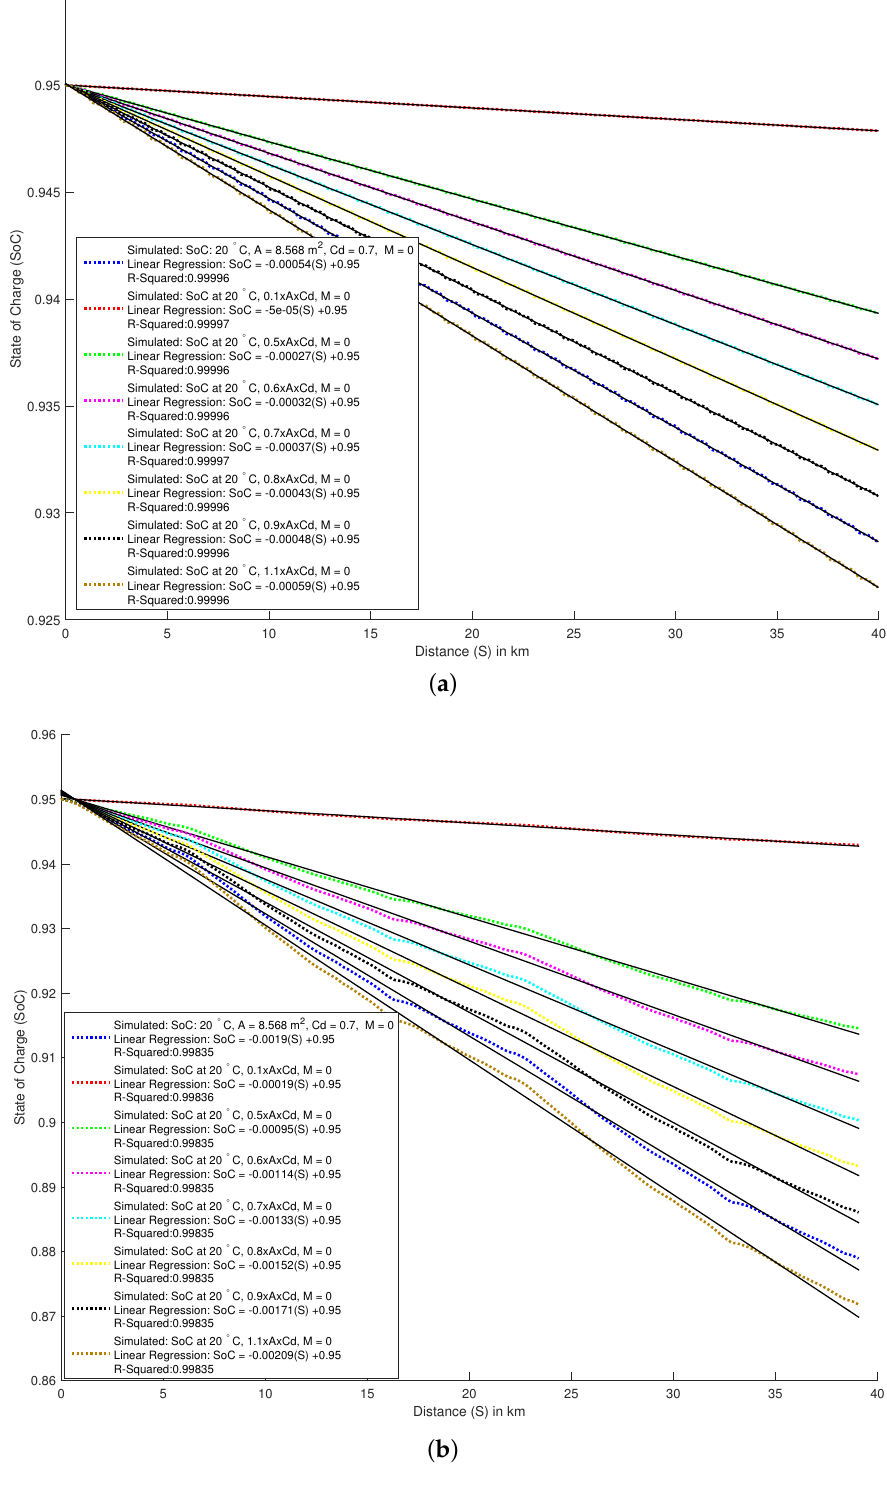
Figure 3. SoC versus distance for different frontal areas of the vehicle: ( a ) SORT 3; and ( b )